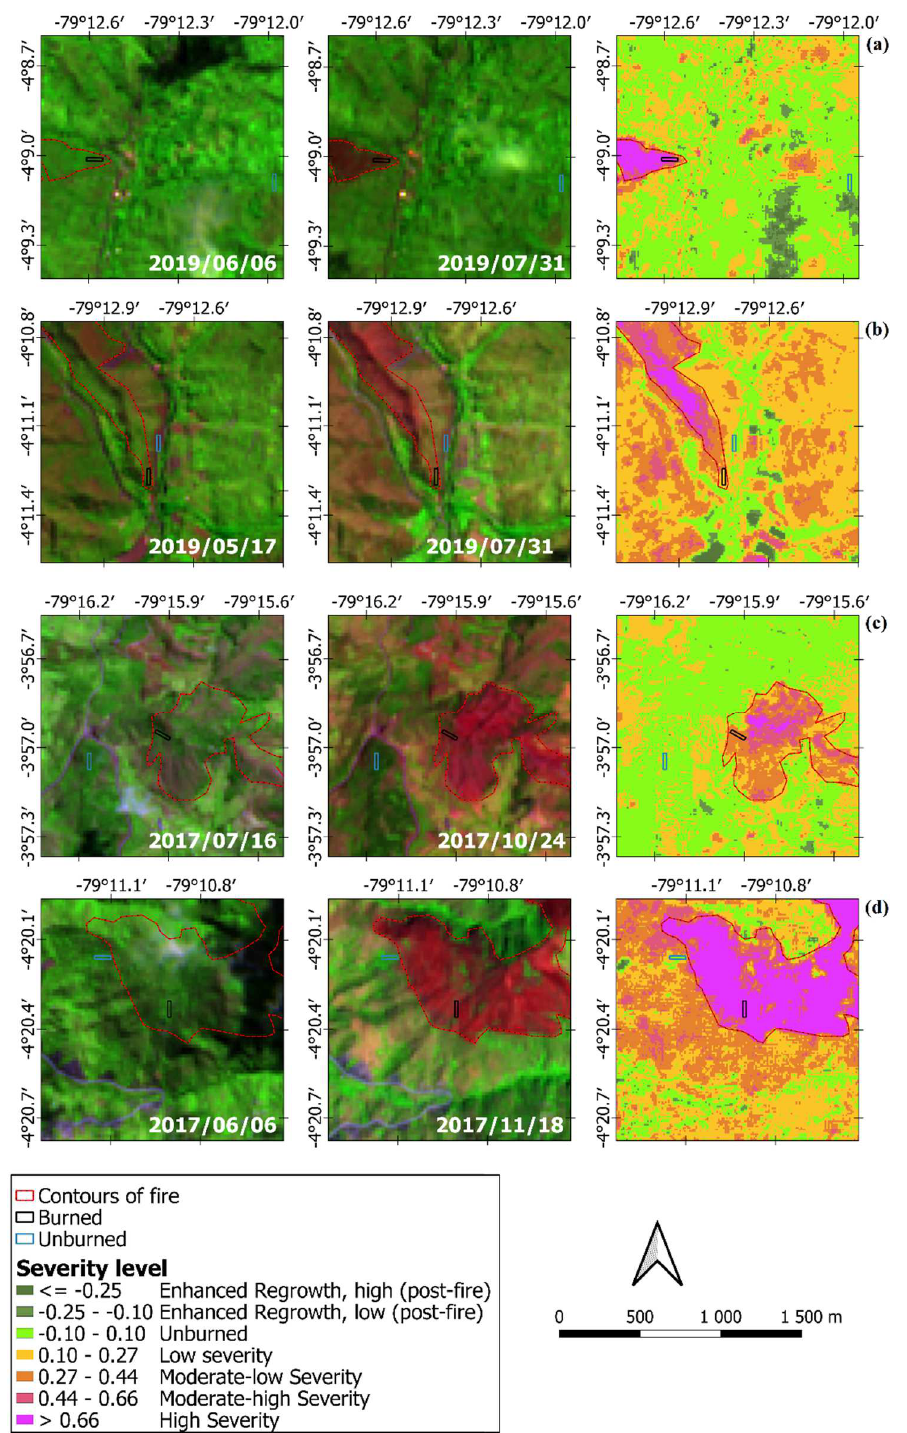
Figure 4. Severity maps according to each sampling site. Scenarios before, after, and severity of the wildfire for burned HMs are presented. In addition, the location of the soil sampling plots for both burned and unburned HMs are presented. ( a ) High severity map—year 2019. ( b ) Low severity map—year 2019. ( c ) Moderate low severity—year 2017. ( d ) High severity map–year 2017. The se- verity map was determined using normalized burn ratio (NBR) and the difference between pre-fire and post-fire (NBR Prefire–NBR Postfire).